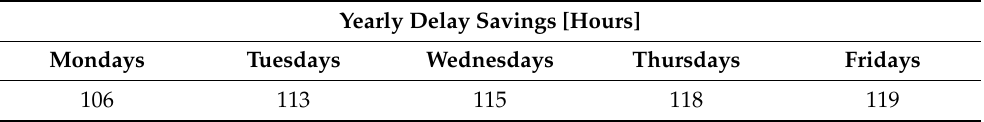
Table 1. Total vehicular delay savings from 9 a.m. to 10 a.m. for all weekdays in a period of one